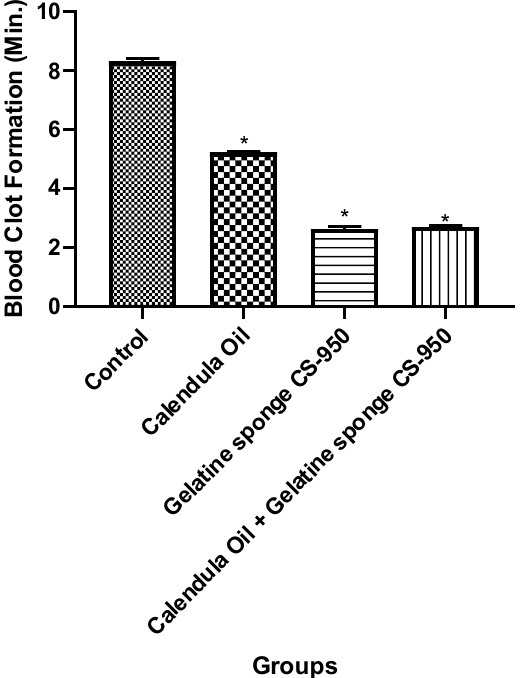
Figure 10. Blood clot formation using Lee–White method. Control tube ( A ) showing Blood clot formed that does not contain any agents, tube ( B ) with blood clot containing Calendula officinalis oil, tube ( C ) contains gelatin sponge, and tube ( D ) containing the test agent 7% Calendula officinalis oil incorporated in gelatin sponge.